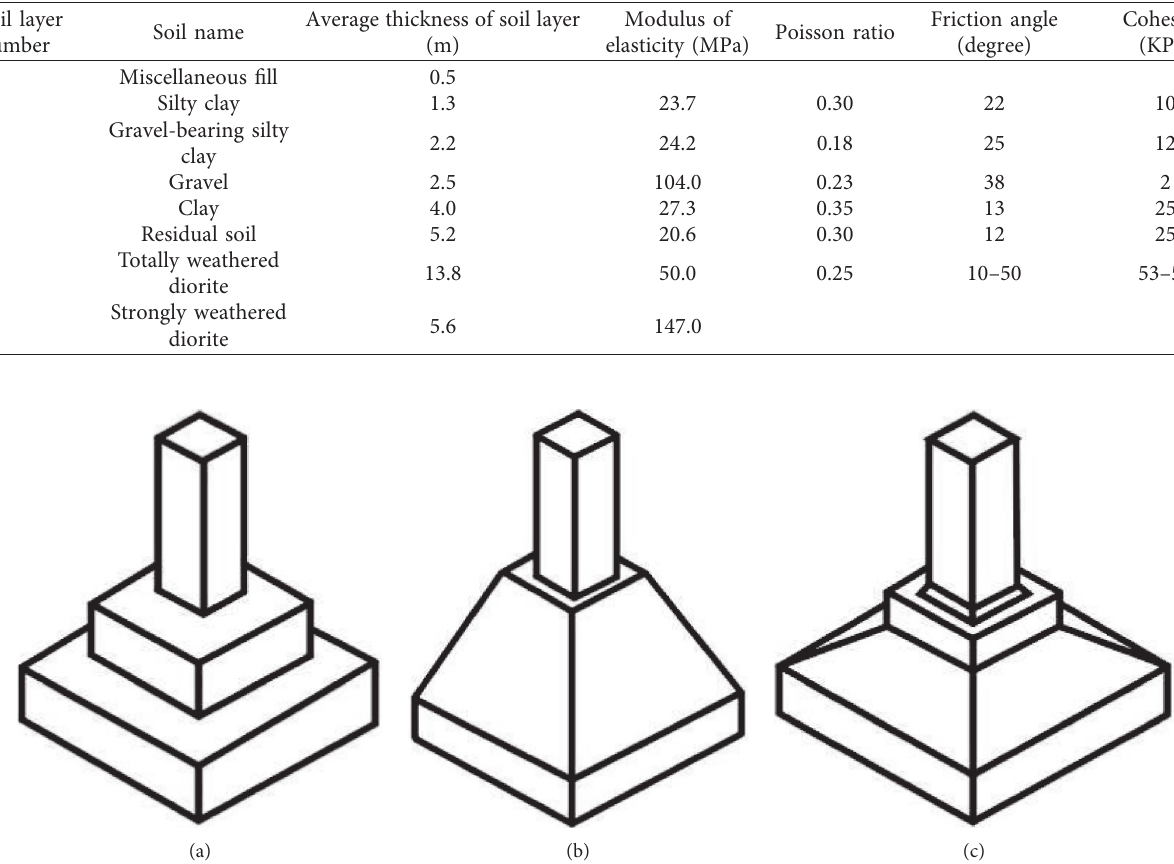
Figure 1: Peripheral stress and deformation of pile